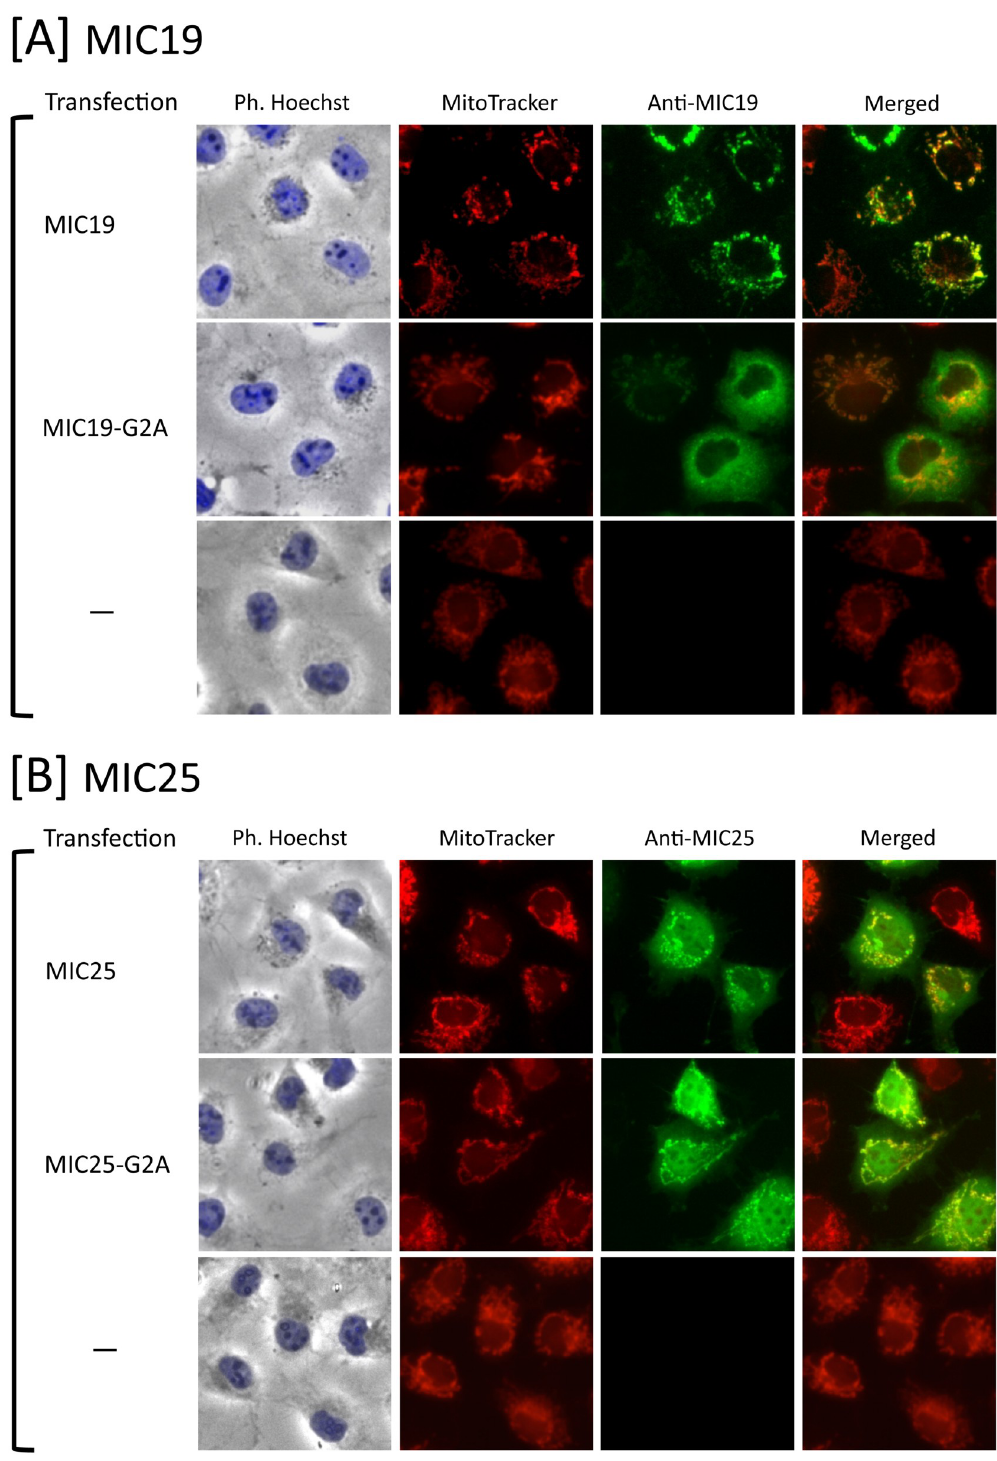
Fig 7. Protein N -myristoylation of MIC19 but not of MIC25 is required for proper targeting to mitochondria. A. Intracellular localization of MIC19 and MIC19-G2A was determined by immunofluorescence staining of COS-1 cells transfected with cDNAs encoding these two proteins using an anti-MIC19 antibody. Mitochondria were detected using MitoTracker Red. The same experiment was performed using non-transfected COS-1 cells as a control. B. Intracellular localization of MIC25 and MIC25-G2A was determined by immunofluorescence staining of COS-1 cells transfected